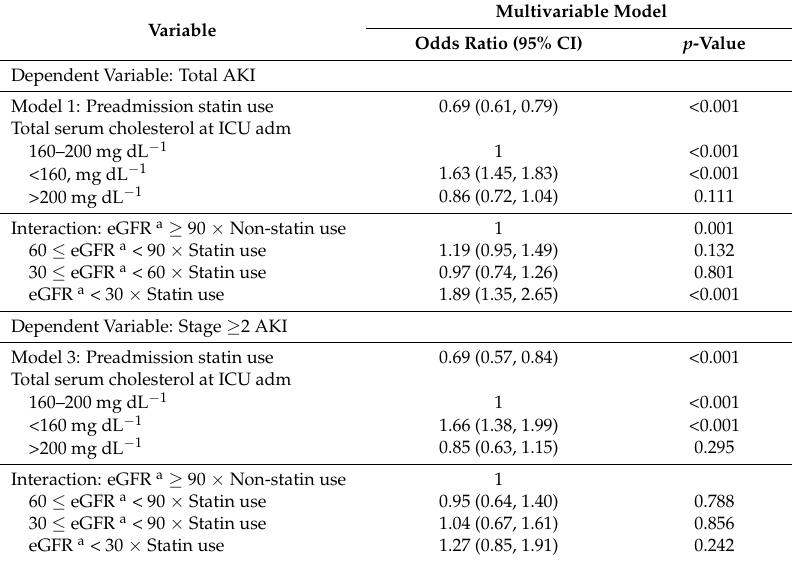
Table 3. Multivariable logistic regression analysis for occurrence of acute kidney injury during 72 h after ICU